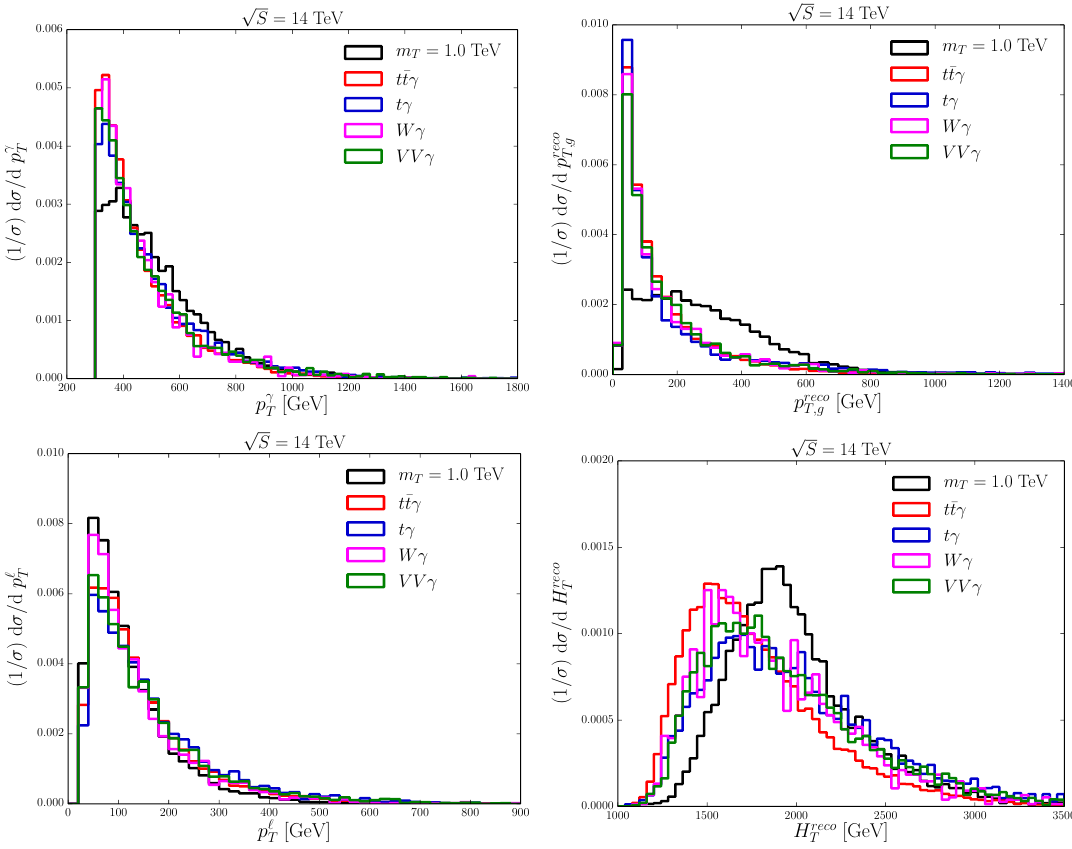
Figure 8 . The p T distributions of the isolated photon (top-left), the hardest slim jet not associated with t had or t lep (top-right), and the isolated lepton (bottom-left) in the ttg(cid:13) channel for m T = 1 : 0 TeV. The scalar sum of the transverse momenta, H reco in eq. (4.32), of the reconstructed T hadronic and leptonic tops, the isolated photon, and the hardest slim jet that is well-separated from the top quarks is shown in the bottom-right panel.